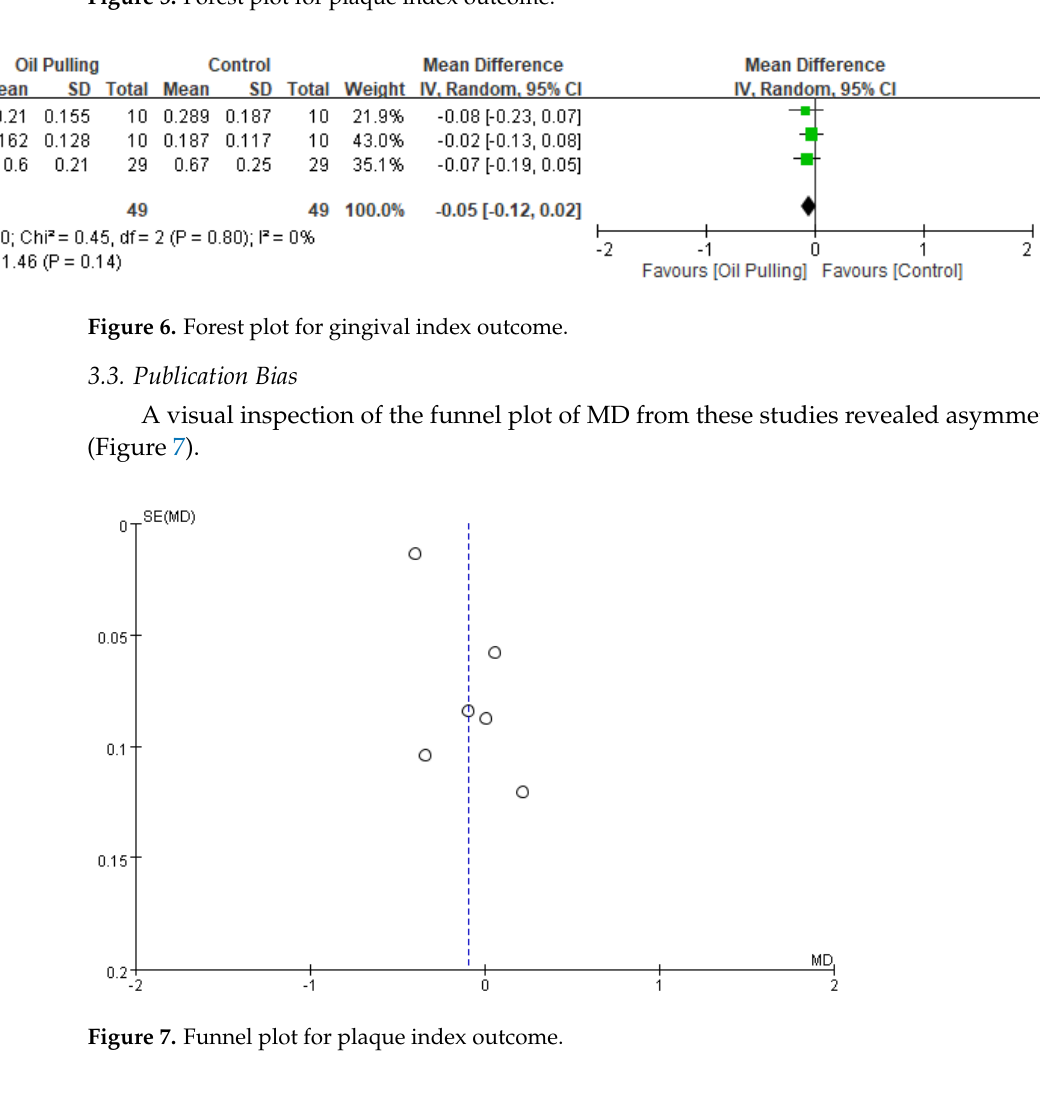
Figure 5. Forest plot for plaque index outcome.